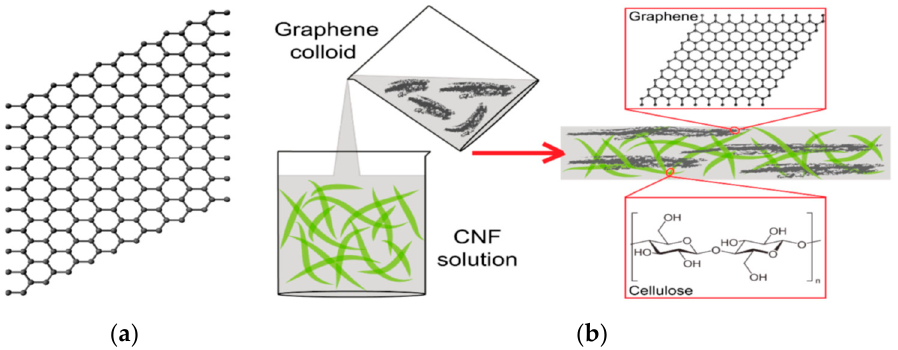
Figure 7. Scheme of ( a ) graphene and ( b ) the preparation and structure of nanocellulose/graphene composites [111].